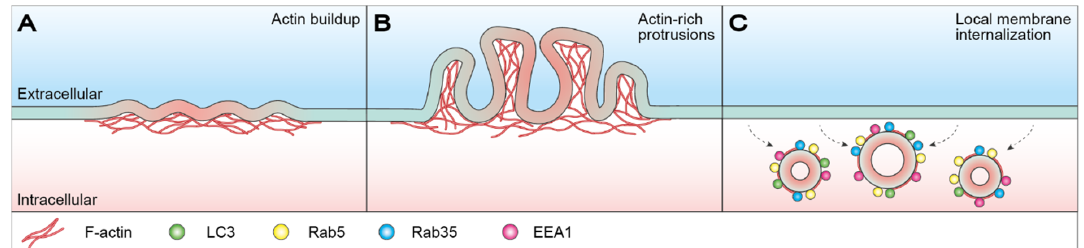
Figure 3. LC3 ‐ asscoiated macropinocytosis ‐ mediated membrane restructuring. ( A ) Subsequent to membrane resealing, actin buildup occurs around the injury site (red) resulting in the formation of actin ‐ rich membrane protrusions. ( B ) Actin ‐ driven extension of PM ruffles generates cup ‐ like structures that close to form large macropinosomes. ( C ) Internalization of macropinosomes via macroendocytic events helps restore membrane integrity as injured membrane regions are removed from the PM. Internalized macropinosomes are initially positive for actin, Rab5, Rab35, EEA1 and occasionally LC3, and eventually undergo potential size ‐ dependent shrinkage before fusing with lysosomes for degradation and recycling. For more details see [129]. EEA1: early endosome antigen 1; LC3: light ‐ chain 3; PM: plasma membrane; Rab5/35: Ras ‐ related protein Rab ‐ 5/35.